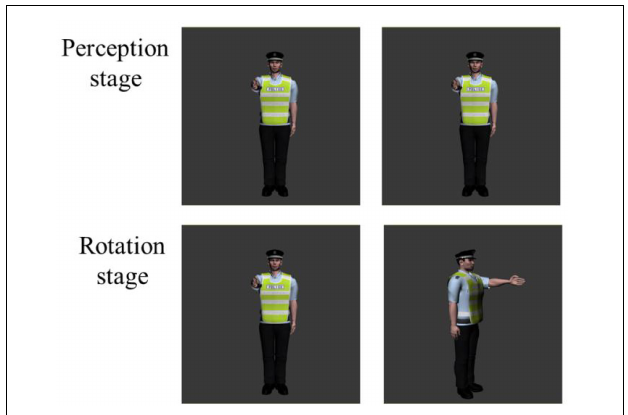
FIGURE 5 | Experimental Materials for subject mental rotation. The first column were original images, and the second column were rotation or mirrored images.